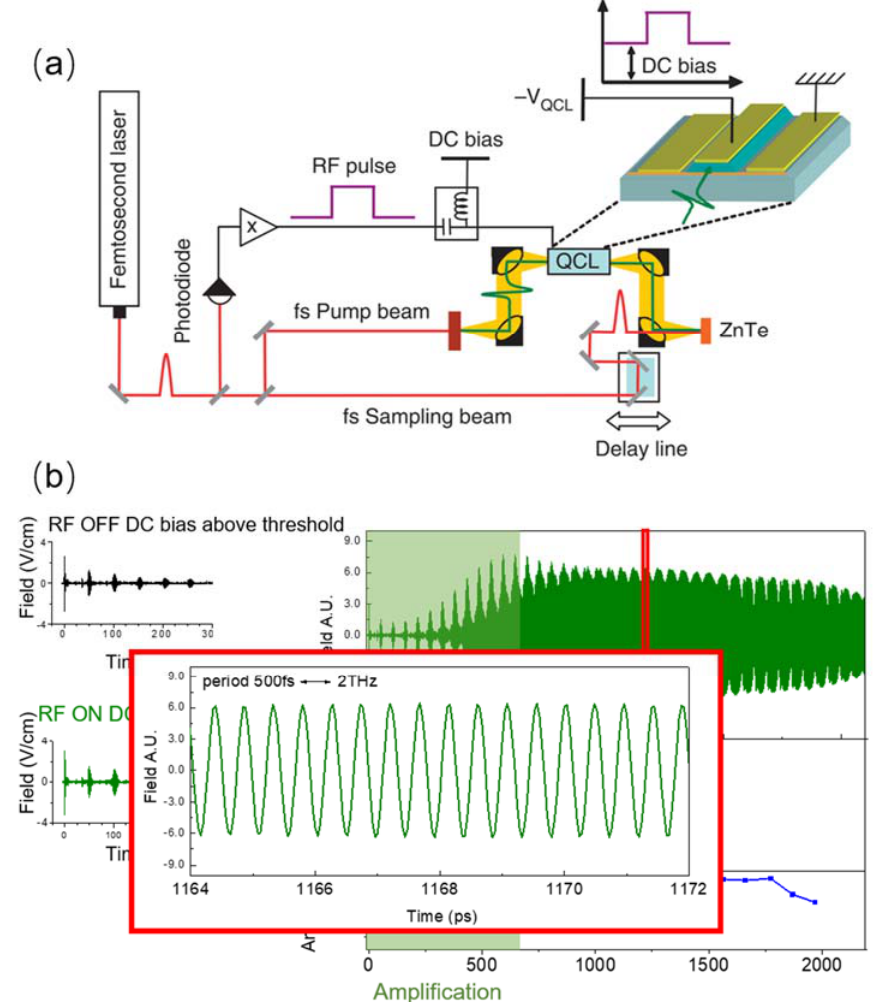
Figure 6. ( a ) Schematic of the experimental setup. RF voltage pulses are generated from a fast photodiode illuminated by the femtosecond laser beam. The RF pulses are amplified by a power RF amplifier. A bias tee adds a DC offset to the RF pulses. THz pulses are generated by illuminating a biased interdigitated antenna with a femtosecond pump beam. The THz pulses are coupled into a facet of the QCL with parabolic mirrors. The QCL output field from the other facet is measured using electro-optic sampling in a ZnTe crystal with a femtosecond sampling. ( b ) The experimental result: full electric field resolved emission of a THz QCL working at 2 THz. (Figure ( a ) from Ref [63],